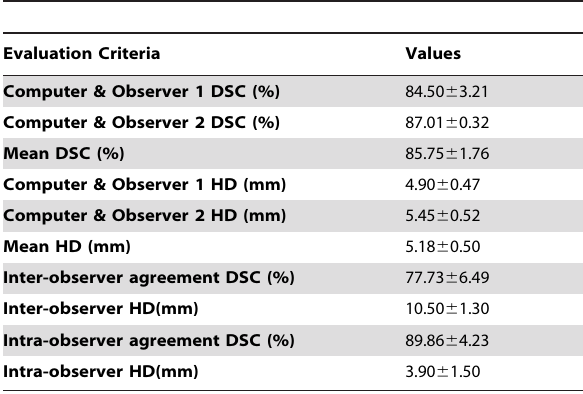
Table 2. Evaluation of the proposed segmentation methods (via DSC and HD) and observer agreement ratios are